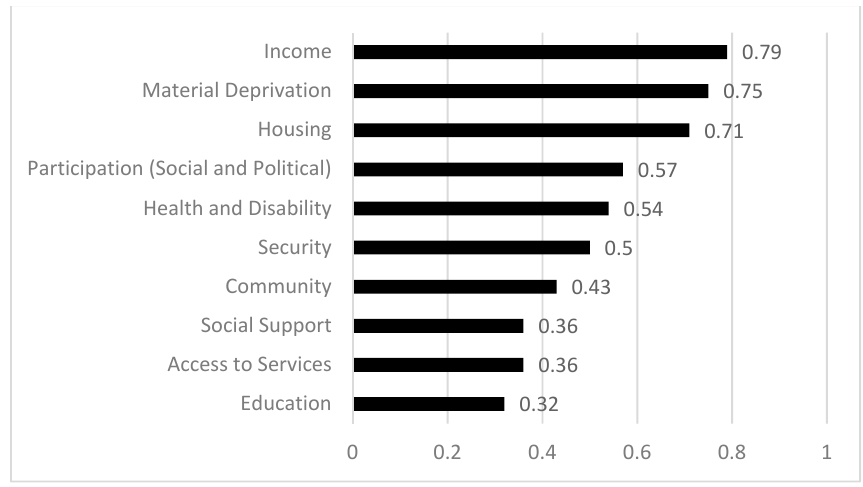
Figure 2. Prevalence of each dimension.